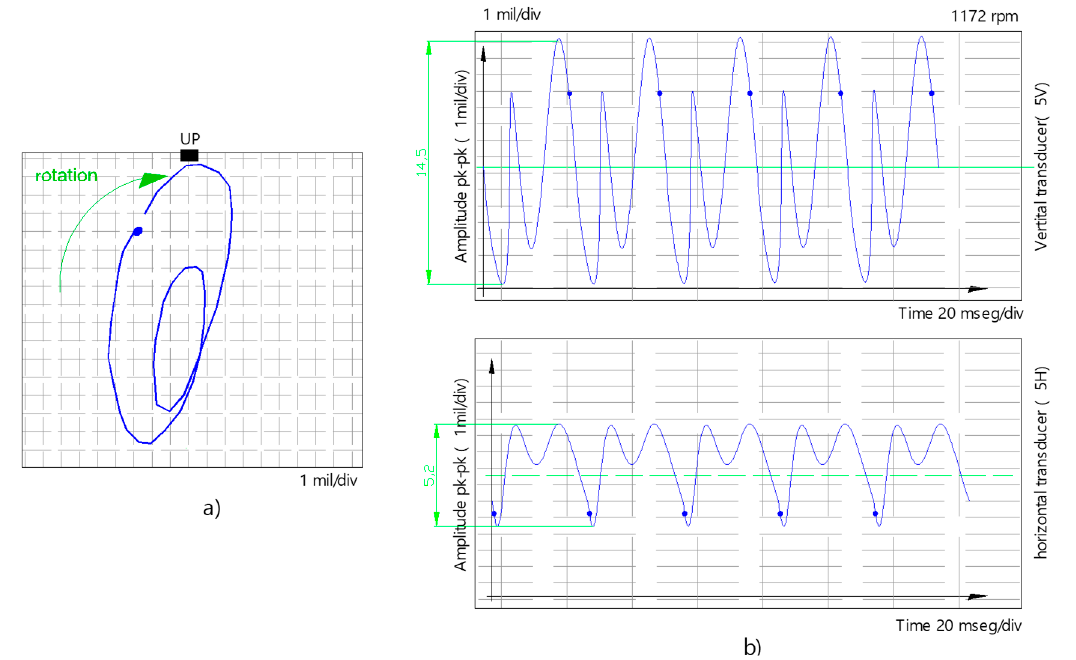
Figure 4. Orbit and amplitude/time (118 N, 7 h).